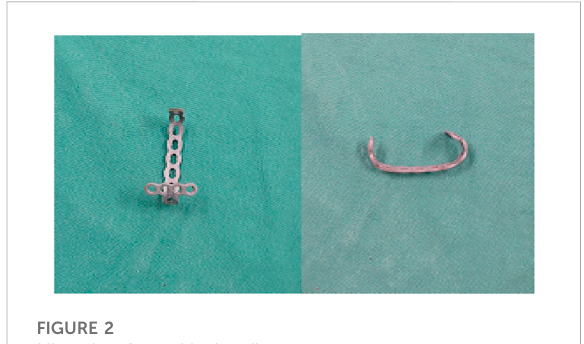
FIGURE 2 Microplate formed by